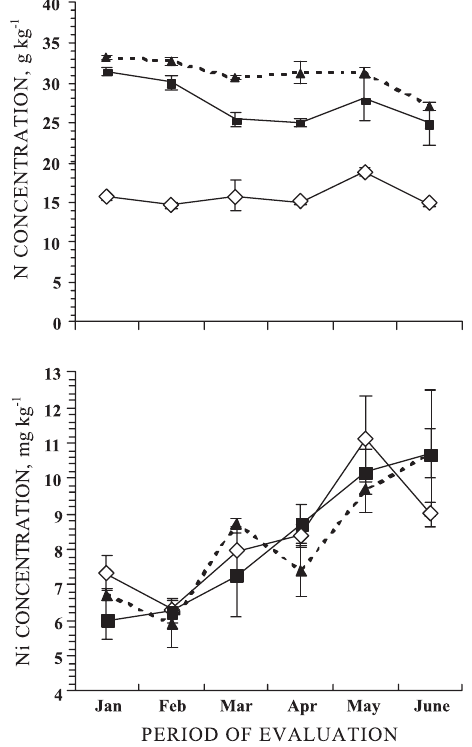
Figure 3. Leaf N and Ni concentrations during the coffee fruit development, considering different N-rates ( control, 150 kg ha -1 and 300 kg ha -1 ). Vertical bars indicate mean standard deviations.